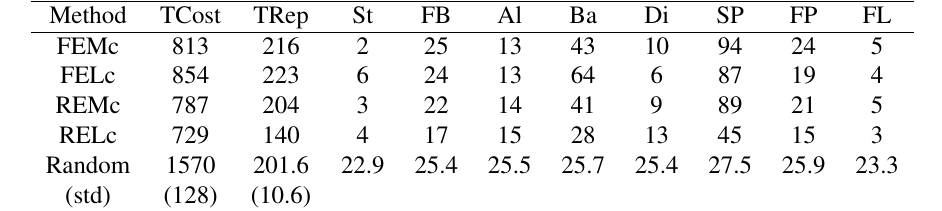
Table 8. DAP-TC results when threshold is 0.75.